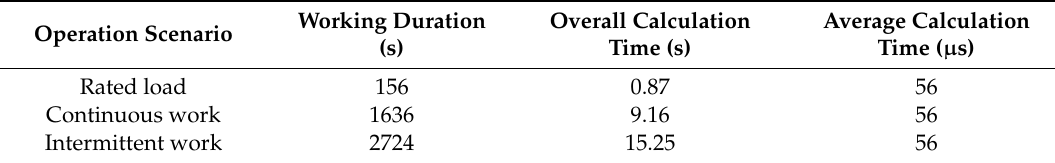
Table 5. Calculation time in